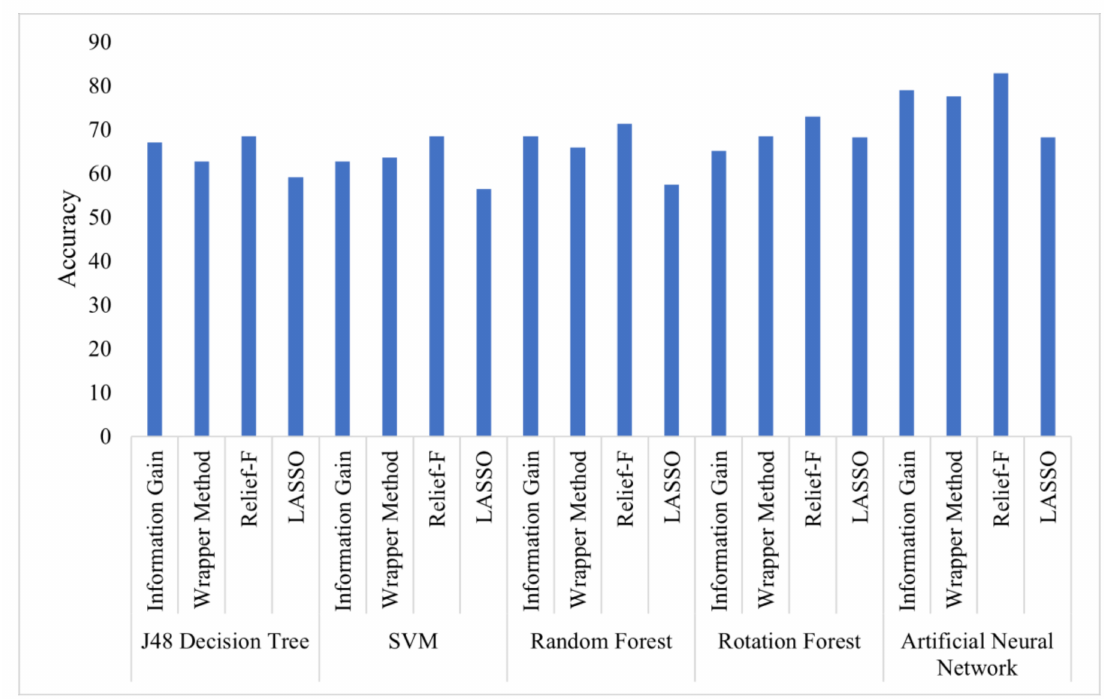
Figure 3. Performance comparison of models based on accuracy with utilisation of various feature selection